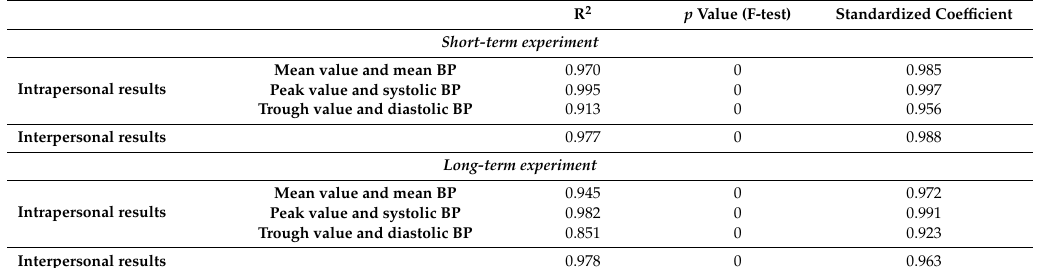
Table 1. Linear regression between the cu ff -based NIBP and the baseline-corrected sensor values.